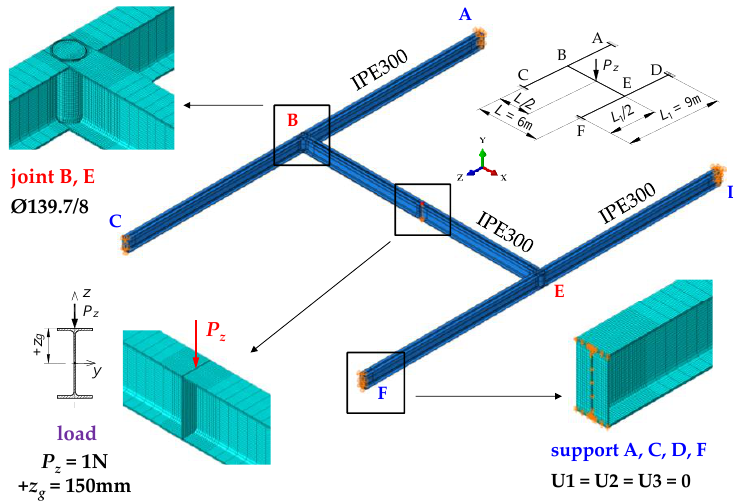
Figure 2. The spatial model of exemplary H-grillage obtained with Abaqus.